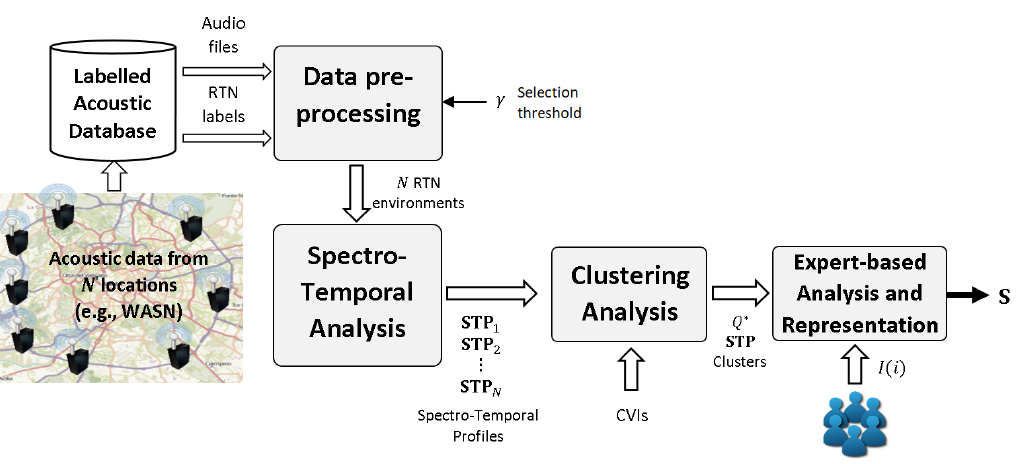
Figure 1. Block diagram of the clustering and analysis methodology of RTN acoustic environments from the data collected from N locations